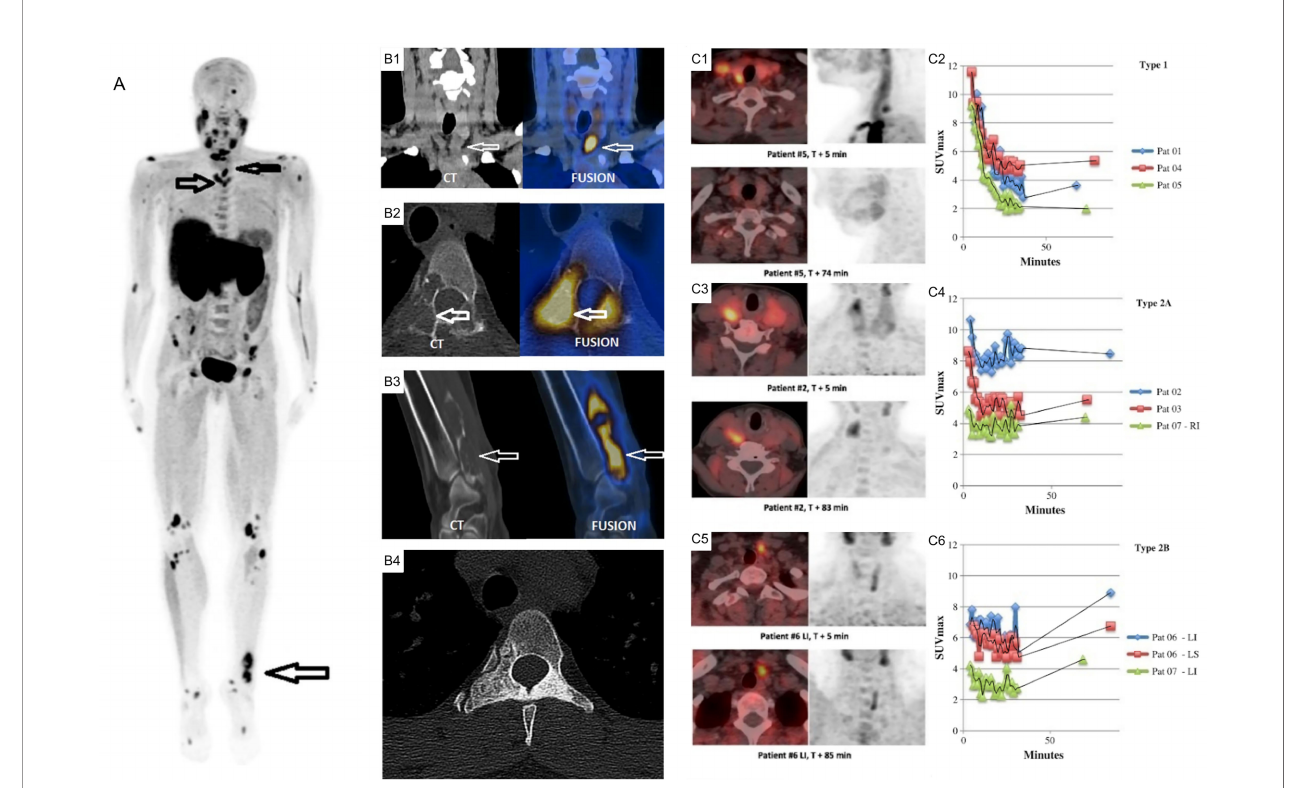
FIGURE 12 | (A) 18F-FCH PET/CT whole body imaging in a patient with severe hyperparathyroidism depicting multiple brown tumors on maximum intensity projection (MIP) images (arrows), coronal CT (left) and fusion PET/CT (right) images depicting parathyroid adenoma (B1) , axial (B2) and oblique (B3) CT (left) and fusion PET/CT (right) images depicting brown tumor (arrows), axial CT depicting sclerotic healed brown tumor (B4) following cure of hyperparathyroidism. (C) Comparison of acquisition protocols for 18F-FCH PET/CT showing cases where an earlier <10 min time point had higher uptake compared to a delayed >60min time point (C1, C2) , cases where earlier and delayed time points where similar (C3, C4) , and cases where the delayed time point had increased uptake (C5, C6) . 18F-FCH, 18F- fl uorocholine. Reproduced with permission from: (A, B) Zhang-Yin J, Gaujoux S, Delbot T, Gauthe ́ M, Talbot JN. 18F-Fluorocholine PET/CT Imaging of Brown Tumors in a Patient With Severe Primary Hyperparathyroidism. Clin Nucl Med. 2019 Dec;44(12):971-974. doi: 0.1097/RLU.0000000000002814. PMID: 31652163 . (C) Morland D, Richard C, Godard F, Deguelte S, Delemer B. Temporal Uptake Patterns of 18F-Fluorocholine Among Hyperfunctioning Parathyroid Glands. Clin Nucl Med. 2018 Jul;43(7):504-505. doi: 10.1097/RLU.0000000000002132. PMID: 29762240